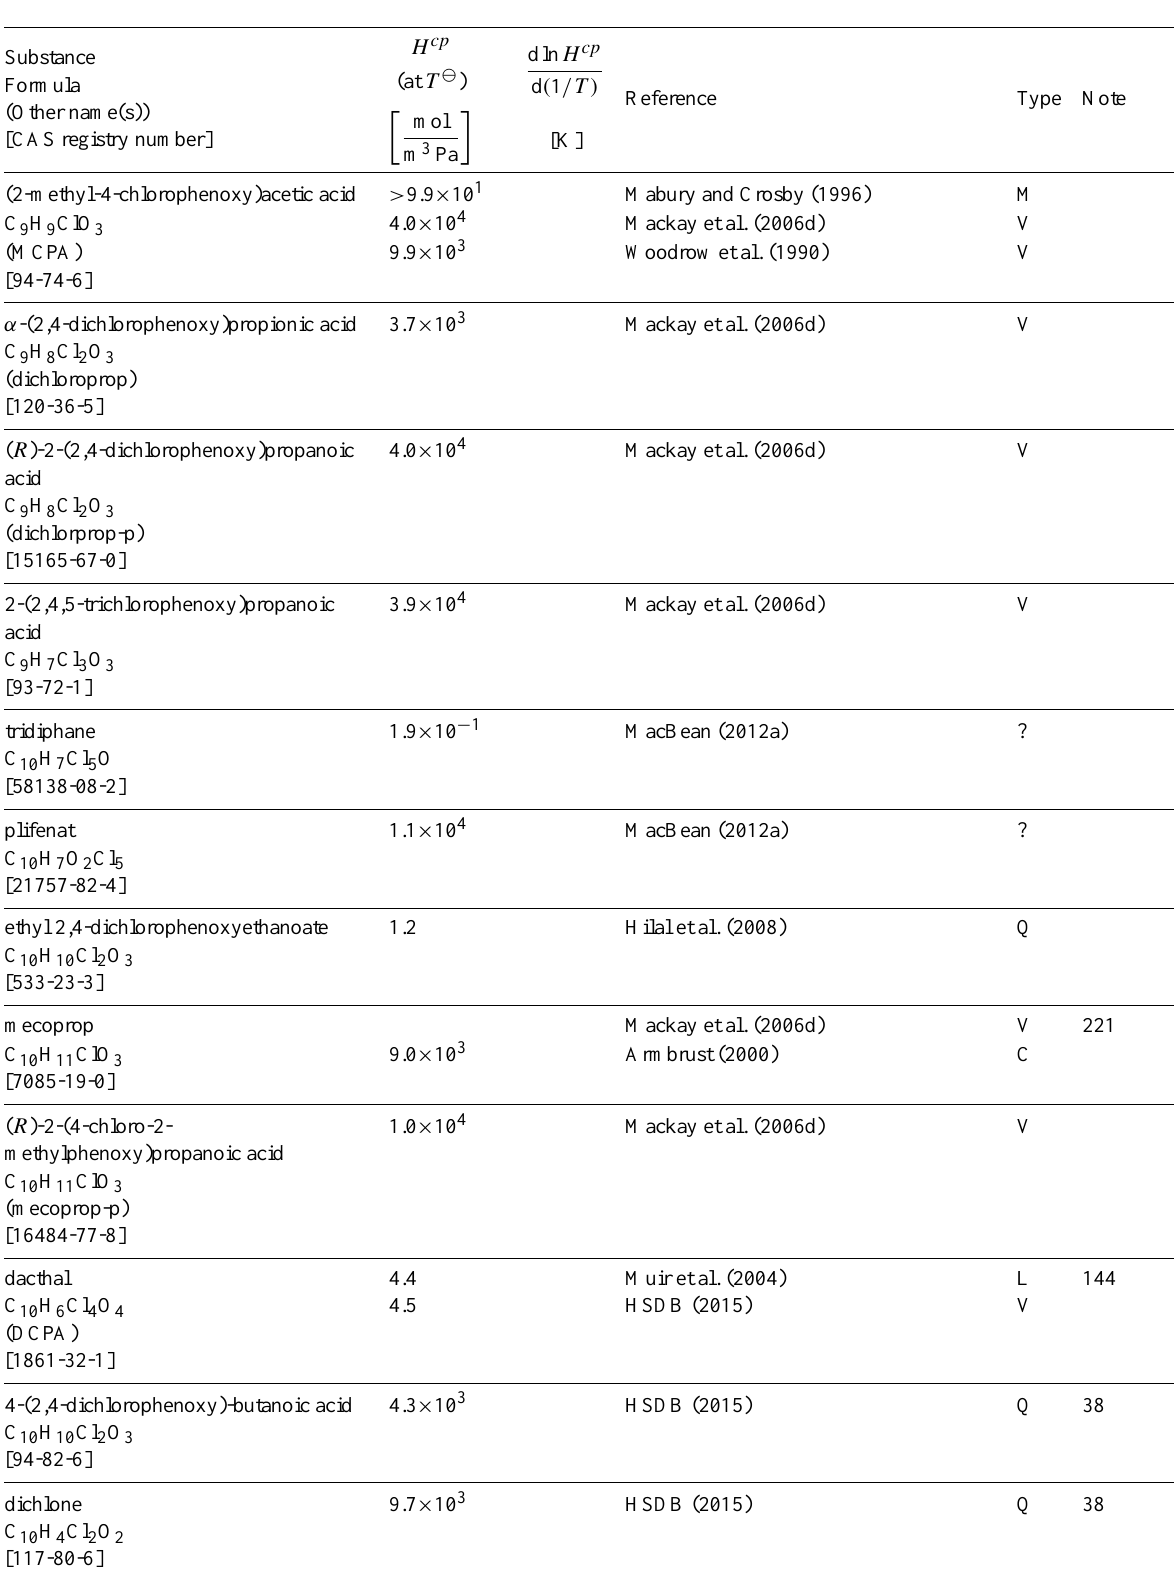
Table 6: Henry’s law constants for water as solvent